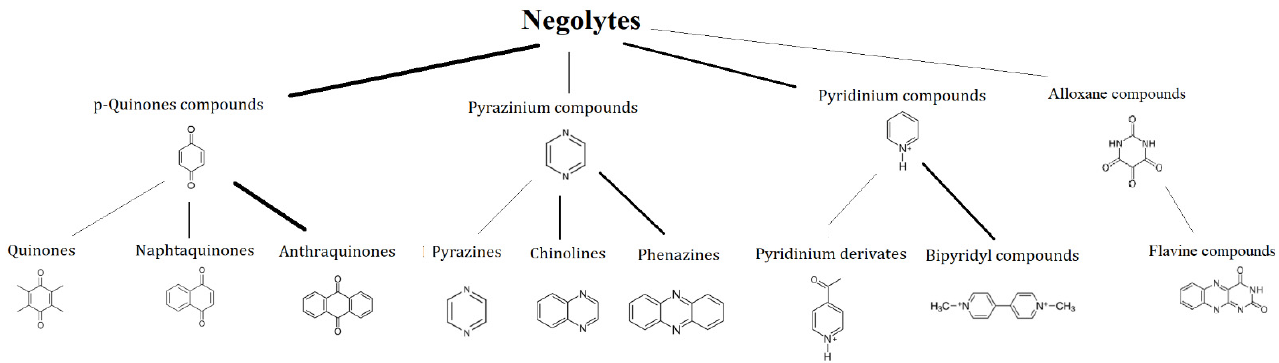
Figure 7: Family tree of the chemical motives for organic redox ‐ active molecules that could act as negolytes in aqueous organic redox flow batteries. Bigger connecting lines indicate more citations in the literature.